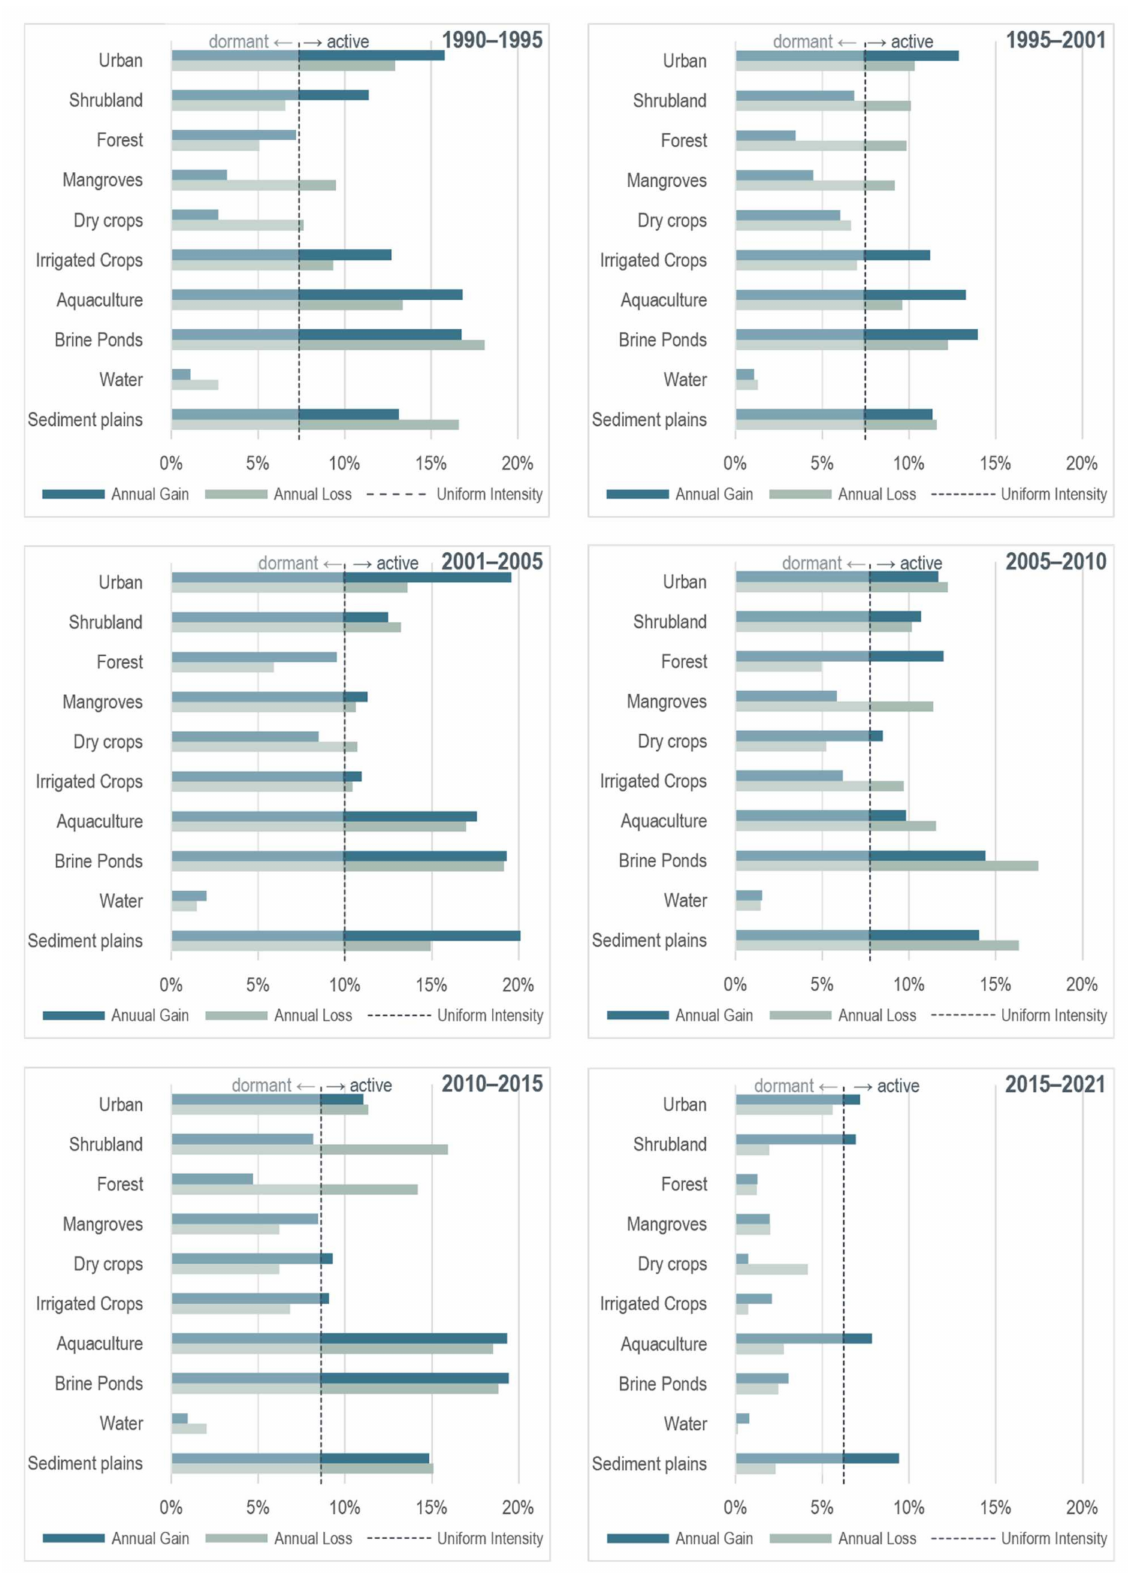
Figure 6. Category intensity analysis for six time intervals between 1990 and 2021 in the Ayeyarwady Delta showing the intensity of annual gains and losses within each LULC